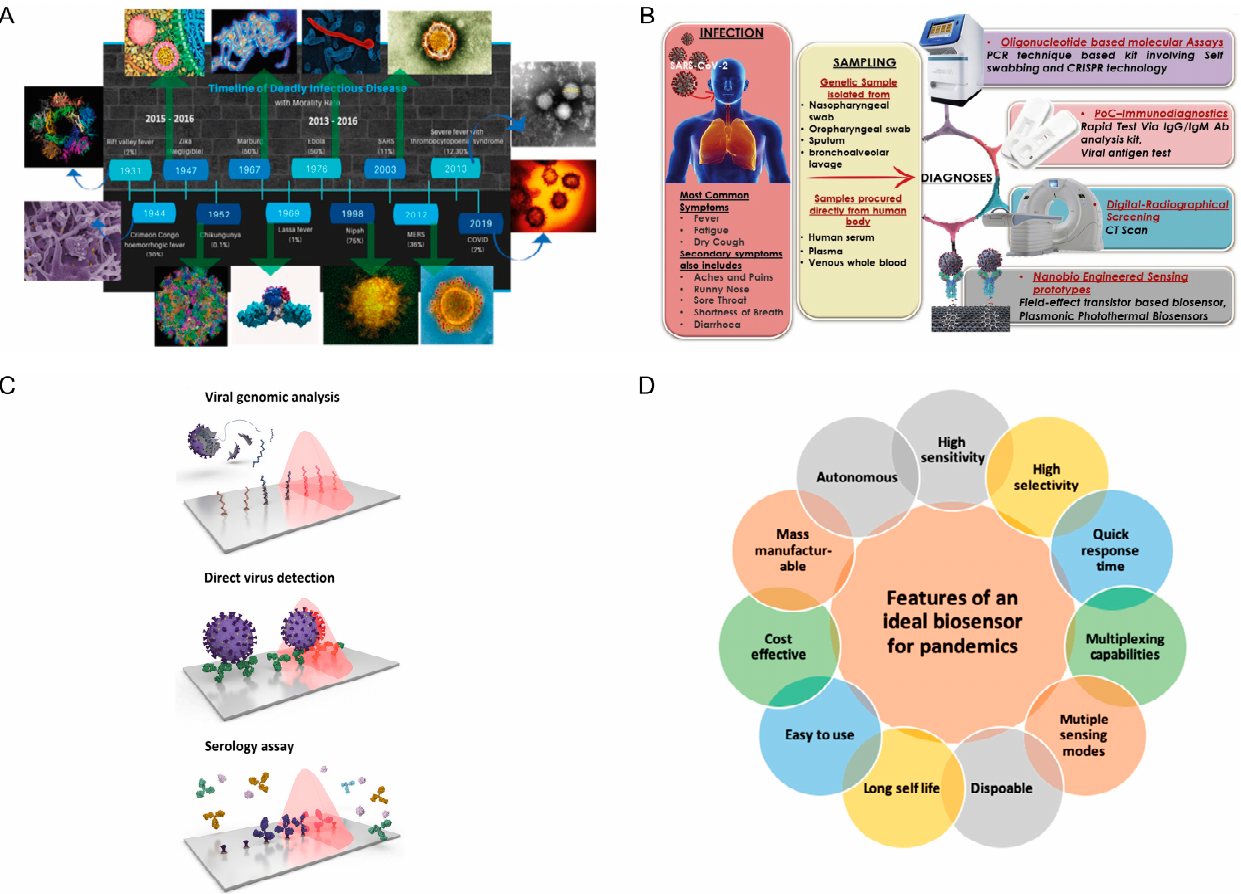
Figure 1. ( A ) Timeline of virus-based diseases. Reprinted with permission from [1], 2021 Elsevier. ( B ) different diagnostic methods for COVID-19. Reprinted with permission from [4], 2020 Elsevier. ( C ) different strategies for biosensing tool development in the COVID-19 outbreak. Reprinted with permission from [5], 2020 American Chemical Society and ( D ) features of an ideal biosensor for pandemics. Reprinted with permission from [16], 2020 American Chemical Society.